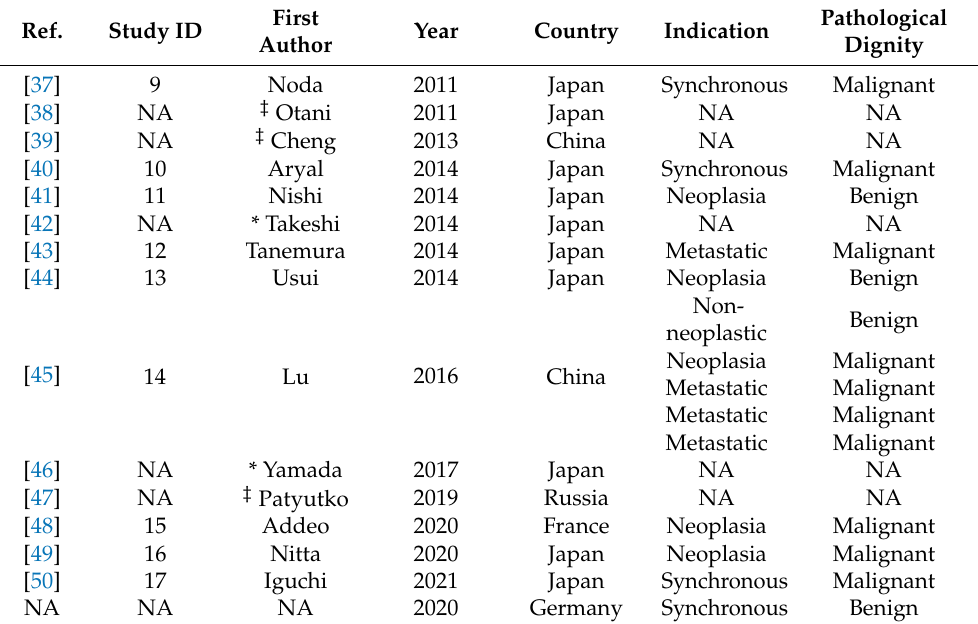
Table 1. Cont. Ref.